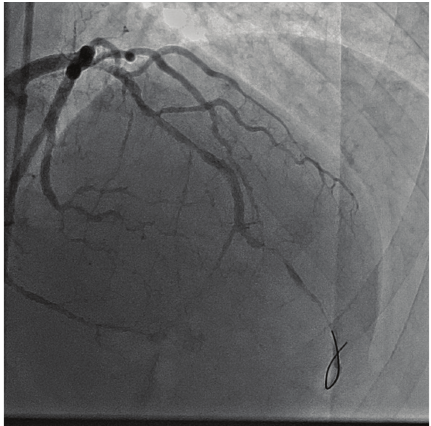
Figure 3: After left anterior descending artery (LAD) recanaliza- tion: severe diffuse disease in the proximal and mid LAD, and severe spasm in its distal